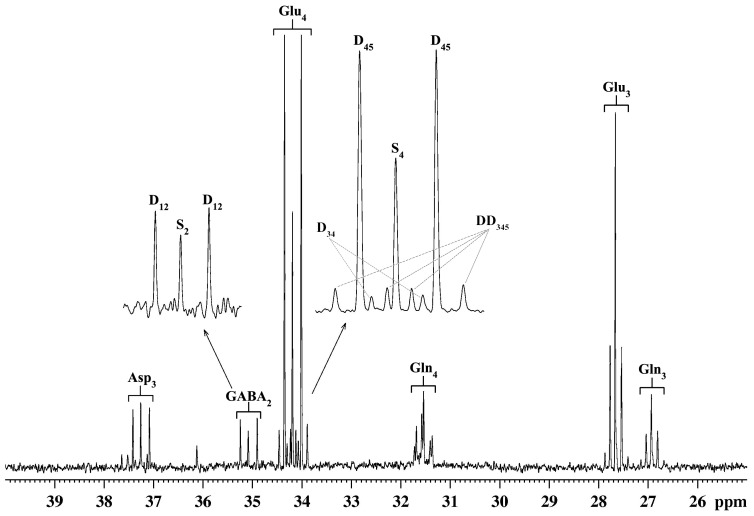
Representative 13C-[1H]-NMR spectrum of cortical tissue extract of nicotine-treated mouse.The inset depicts the resonances for Glu4 and GABA2. In Glu4, D45 and DD345 represent [4,5-13C2]glutamate and [3,4,5-13C3]glutamate, and are the product of glucose metabolism in the first and second turn of the TCA cycle, respectively. S4 and D34 indicate [4-13C]glutamate and [3,4-13C2]glutamate which are labeled from [4-13C]glutamine and [3,4-13C2]glutamine, respectively. [4-13C]Glutamine and [3,4-13C2]glutamine are the products of [2-13C]acetate metabolism in the first and second turn of the astrocytic TCA cycle, respectively. In GABA2, D1,2 represents [1,2-13C2]GABA which is the product of direct metabolism of [U-13C6]glucose in the GABAergic TCA cycle, while S2 ([2-13C]GABA) is the result of the labeling from [2-13C]acetate via astrocytic TCA cycle followed by trafficking into GABAergic neurons.